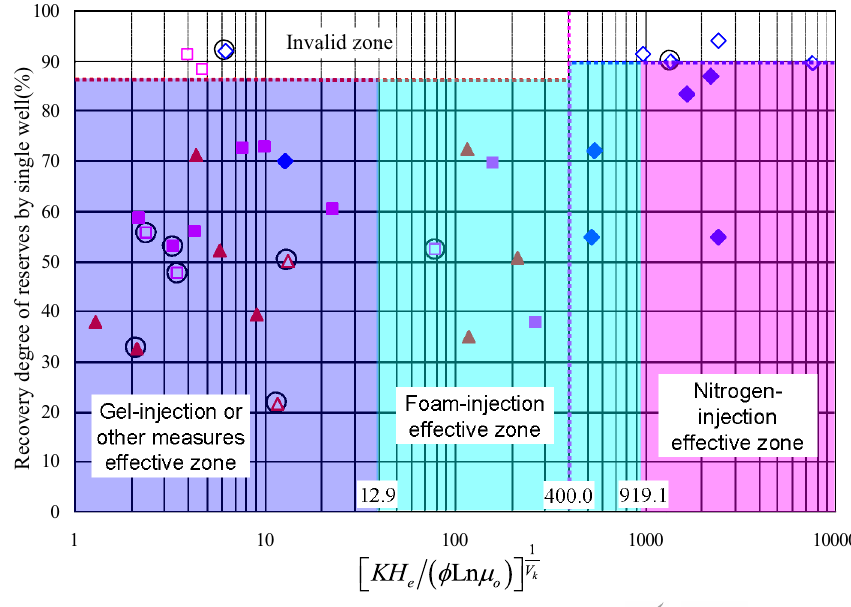
Fig. 7 A diagram of measure selection for different type of low production wells of thermal